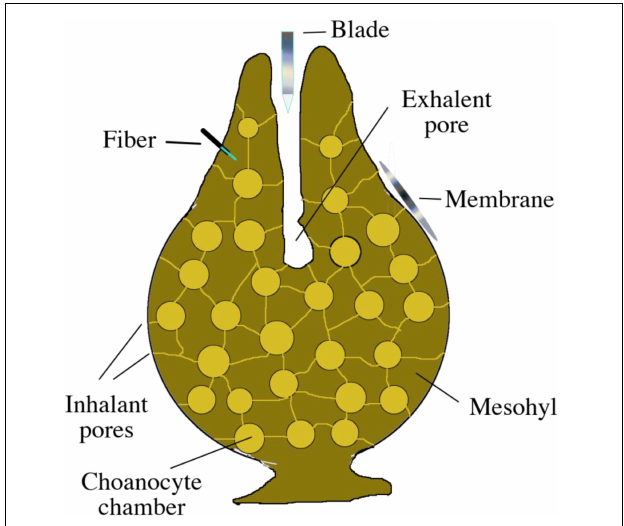
FIGURE 2 | Basic schematic of a sponge’s anatomy, displaying the placement of the three different types of SPME devices during in situ